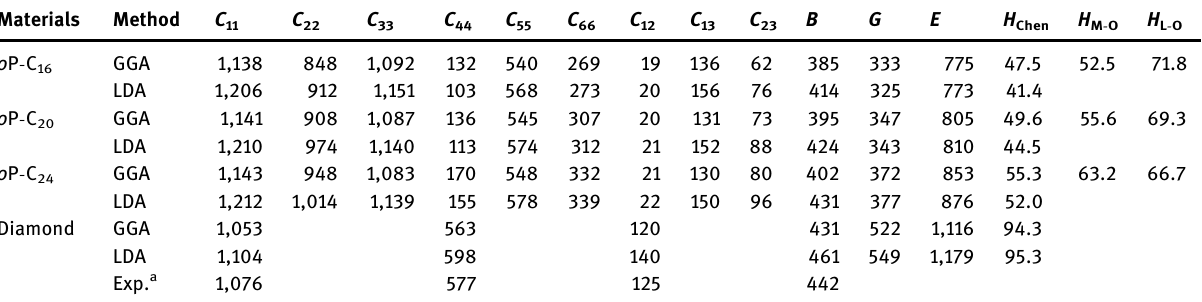
Diamond a Ref. [ 47 ] .